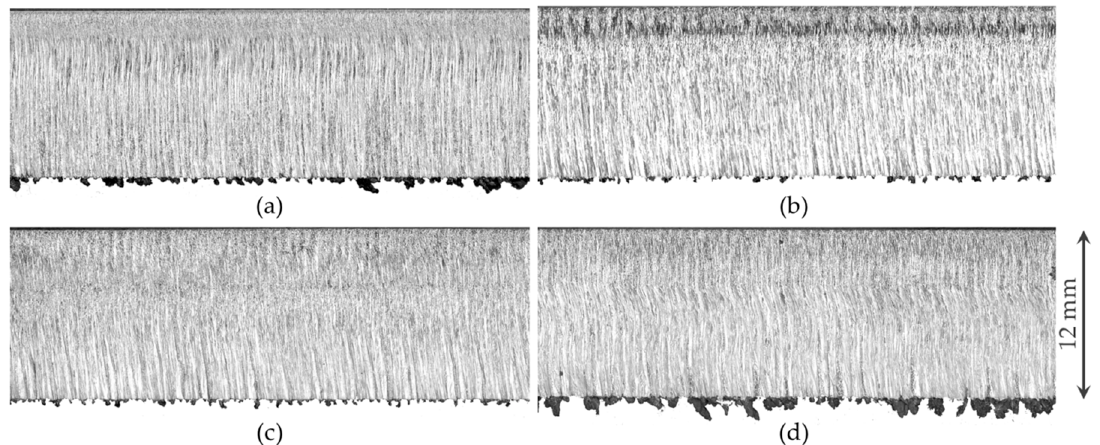
Figure 9. Cut edges of 12 mm stainless steel cut with the following parameters: ( a ) Set #1: Static beam shaping; and different values of the longitudinal, linear beam oscillation parameters; ( b ) Set #2: 300 µ m amplitude and 500 Hz frequency; ( c ) Set #3: 550 µ m amplitude and 500 Hz frequency; ( d ) Set #4: 300 µ m amplitude and 2000 Hz frequency.